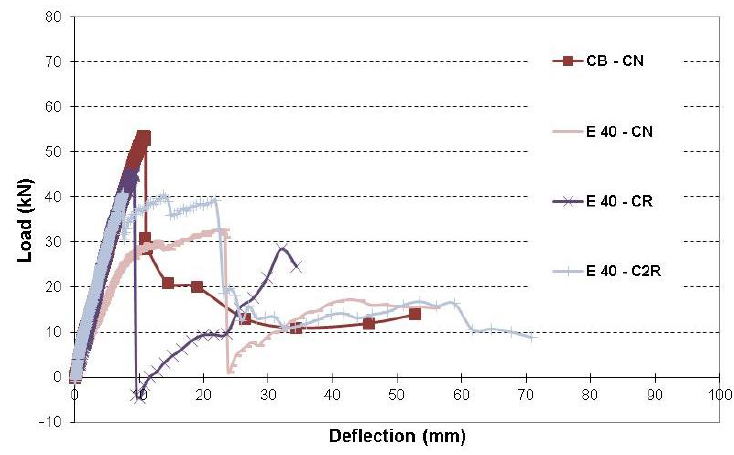
Figure 28. Load-deflection of control beam and beams with 40% corrosion level.